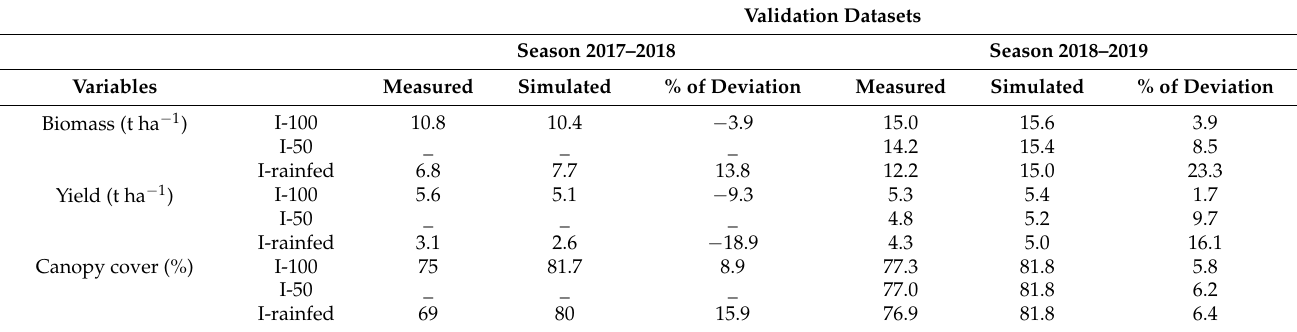
Table 6. Simulation results for the validation data set and deviation from measured values.